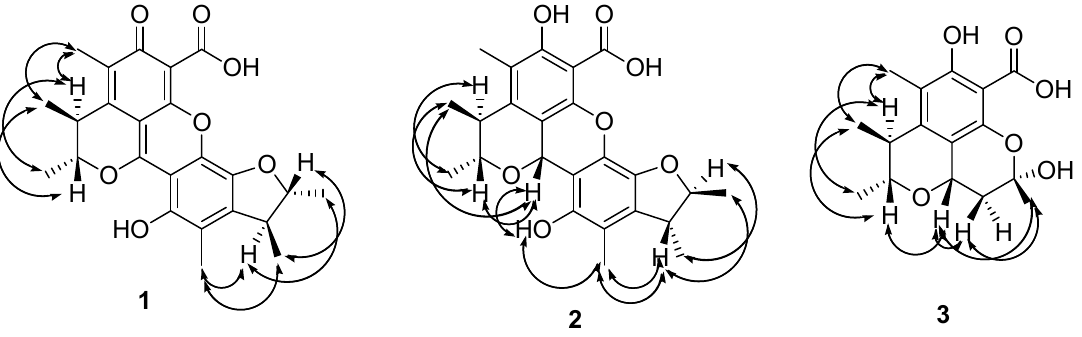
Figure 3. Key NOESY effects of compounds 1 – 3